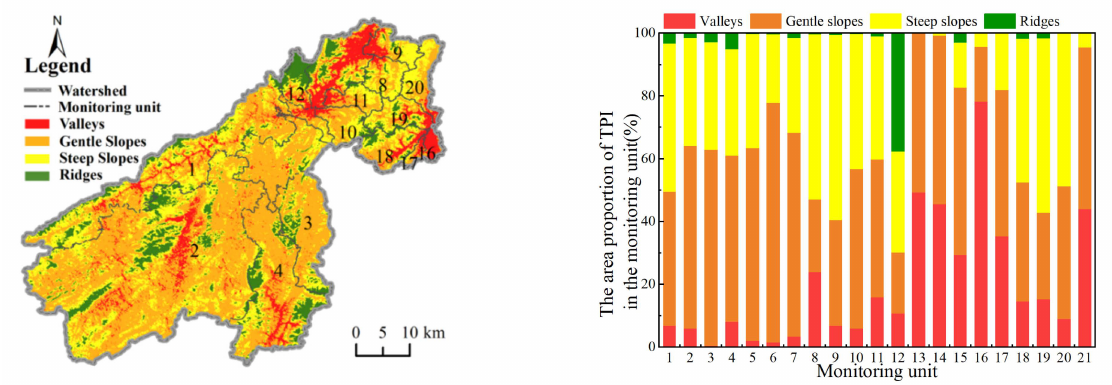
Figure 11. Spatial distribution of topographic position and topographic position composition in each monitoring